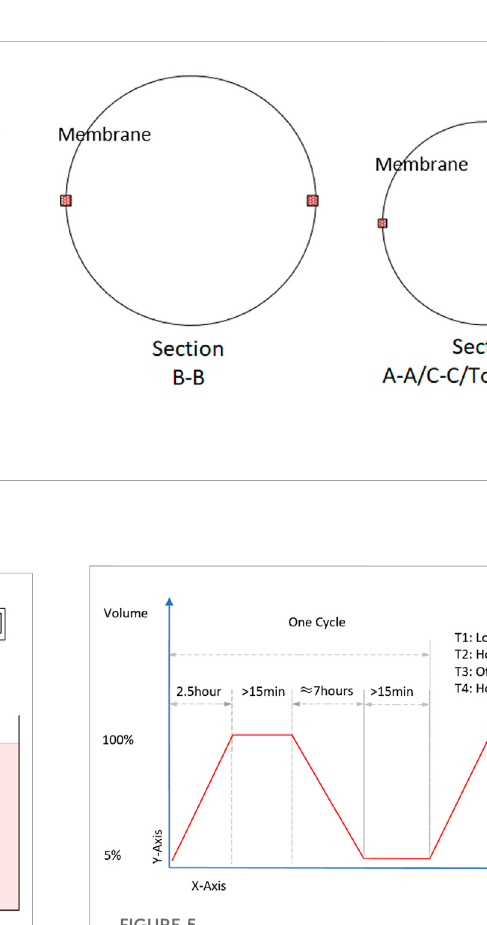
FIGURE 5 Volume – time curve for loading/of fl oading